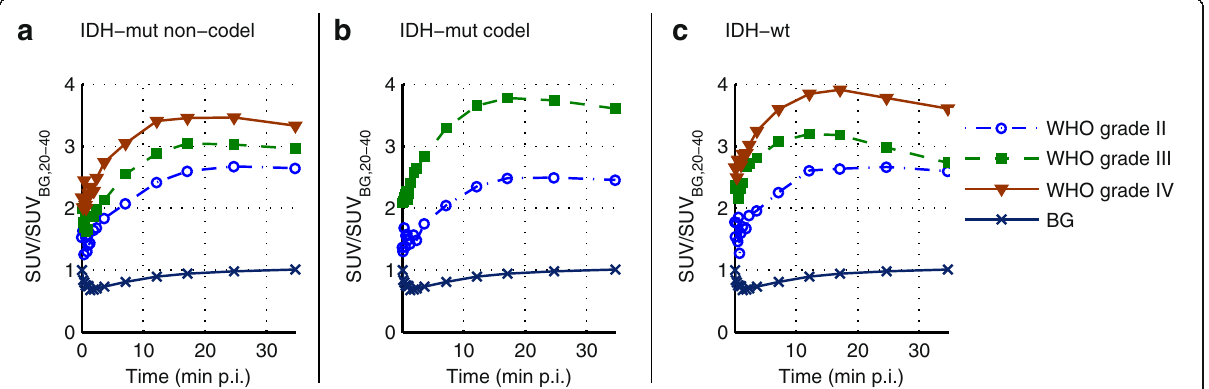
Fig. 1 Average over mean time-activity curves of all patients for tumour volumes delineated with a threshold of 90% times maximum activity: a IDH -mut non-codel, b IDH -mut codel, and c IDH